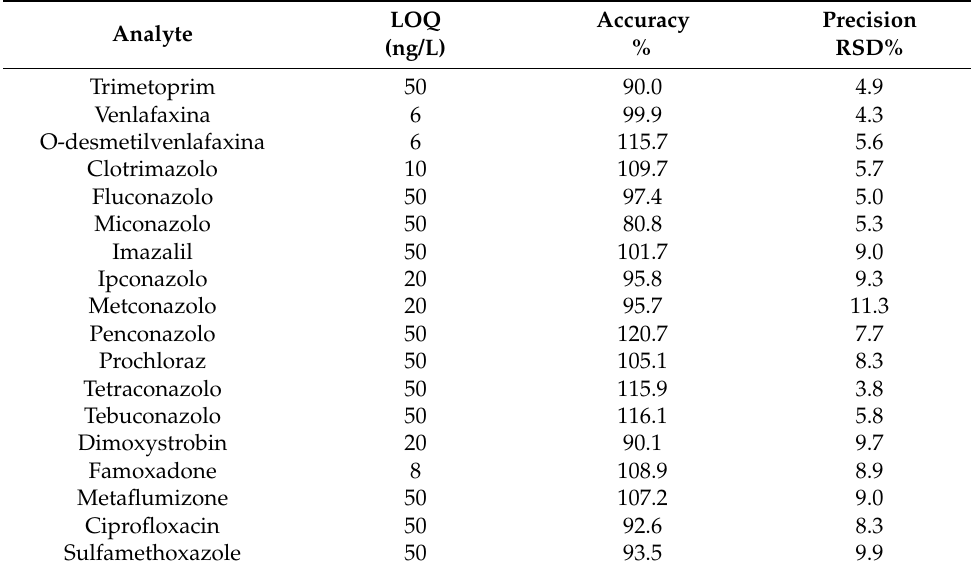
Table 4. Accuracy and Precision calculated at LOQ